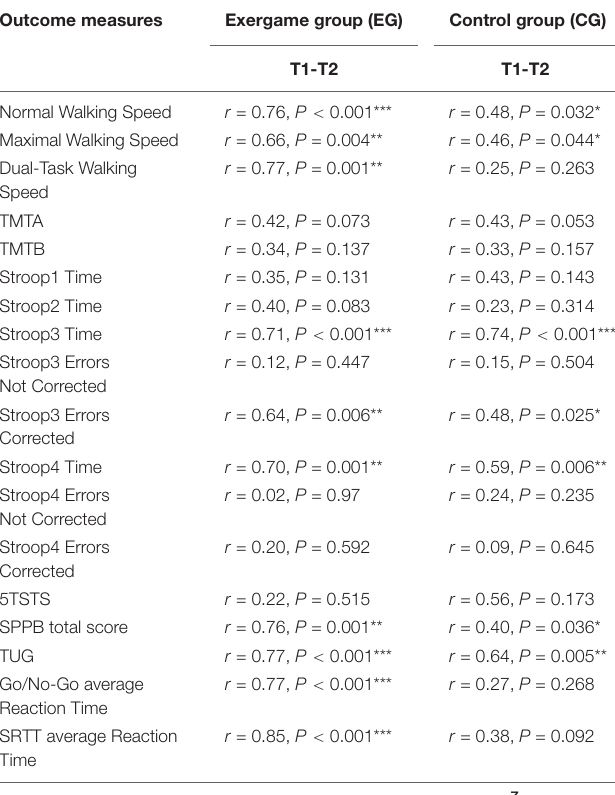
TABLE 4 | Effect sizes representing change over time in each